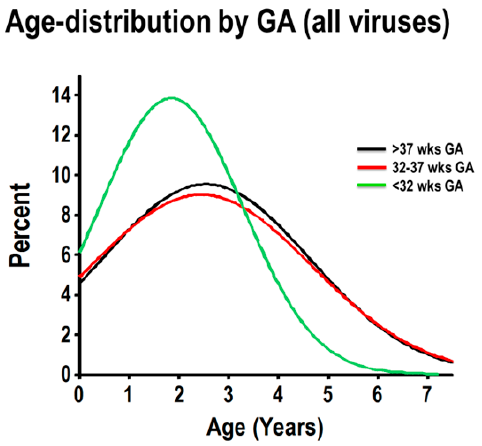
Figure 2. Normalized age distribution analysis of viral respiratory infections according to GA. Combined frequency of viral respiratory infections in children born full-term (black), preterm (red) and severely premature children (green).